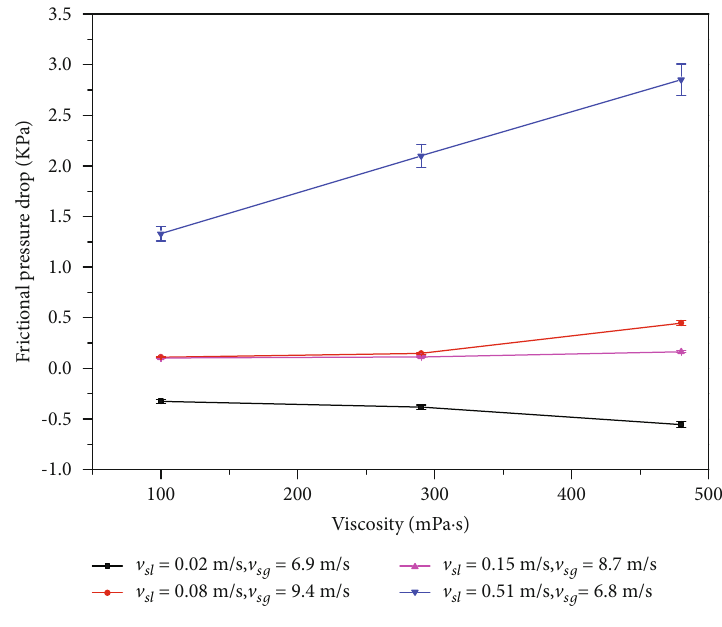
Figure 5: Frictional pressure drop vs. viscosity.